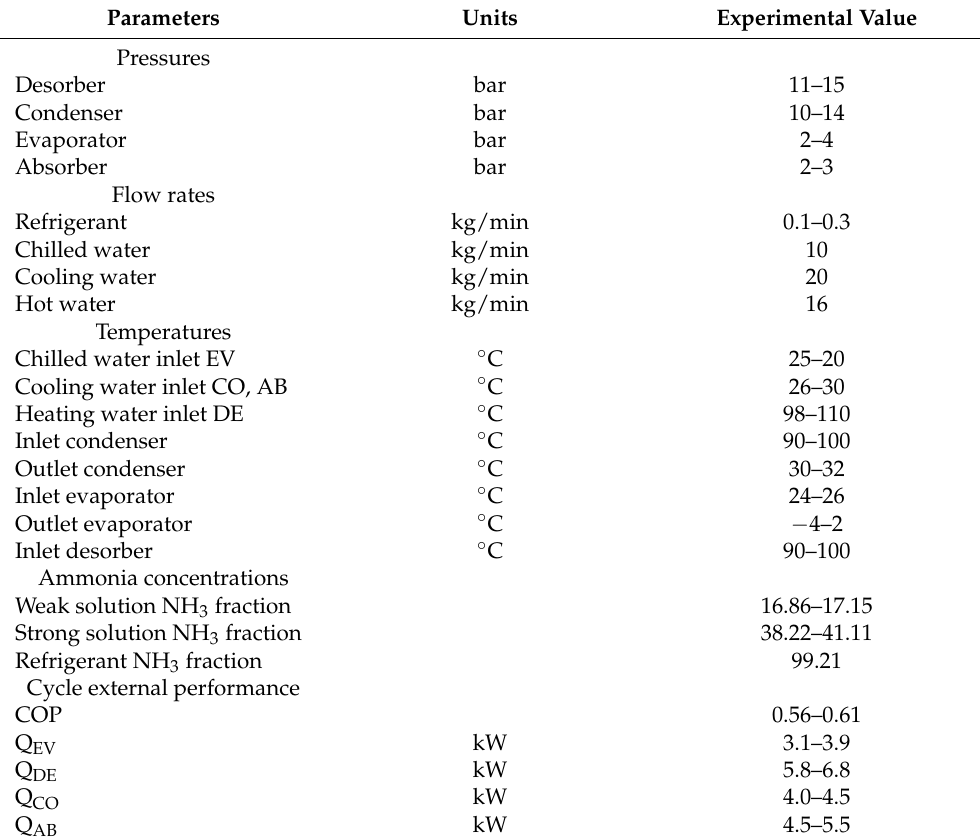
Table 2. Range of operating conditions of the thermal